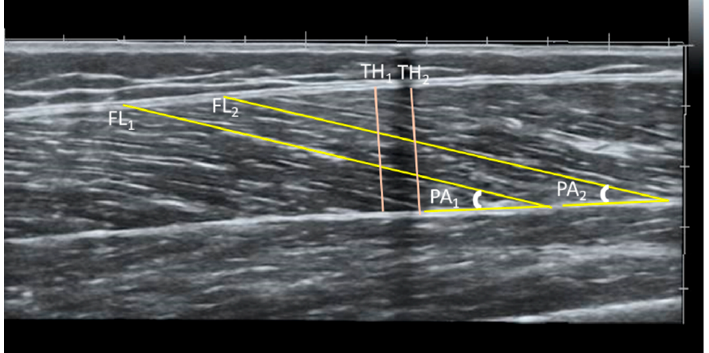
Figure 2. Panoramic sonographic image of VL at the middle part showing FL: fascicle length, PA: pennation angle and TH: muscle thickness.